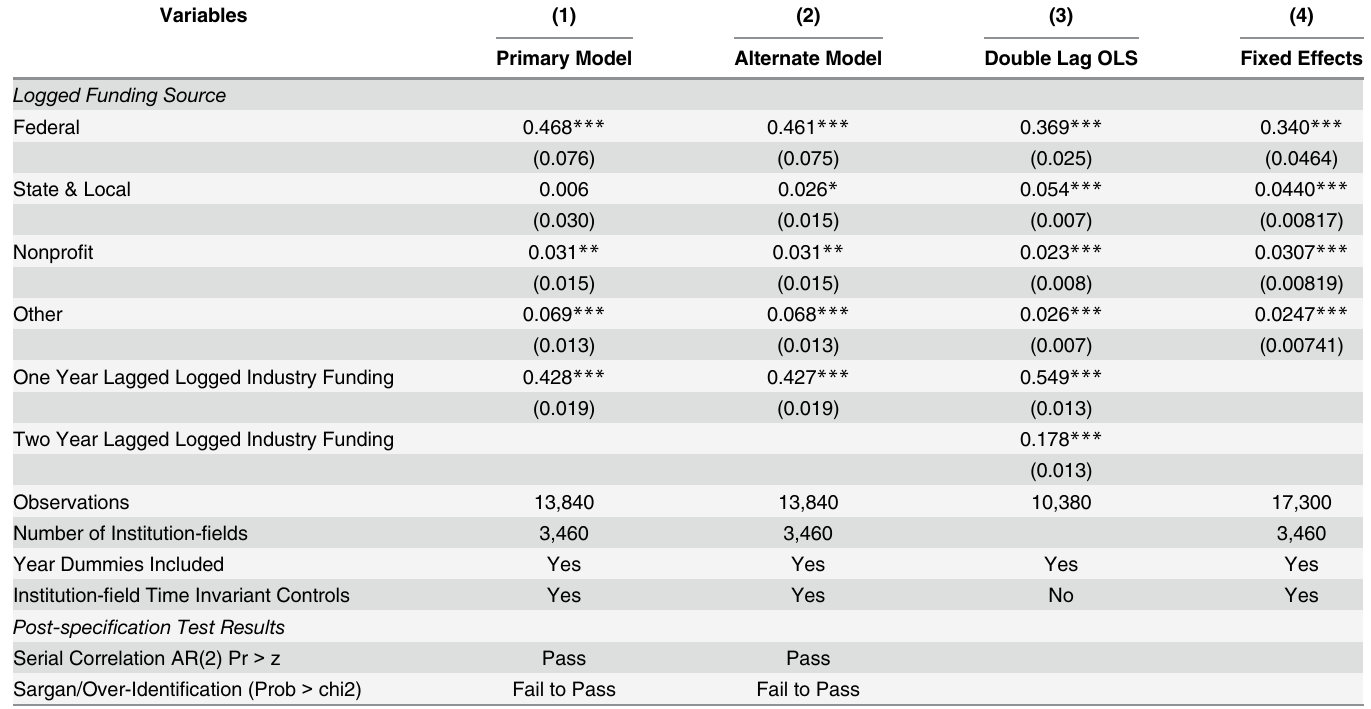
Table 6. Industry R&D Log Expenditure Regression Results, Additional Model